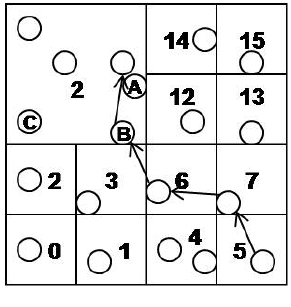
Figure 5. Example of